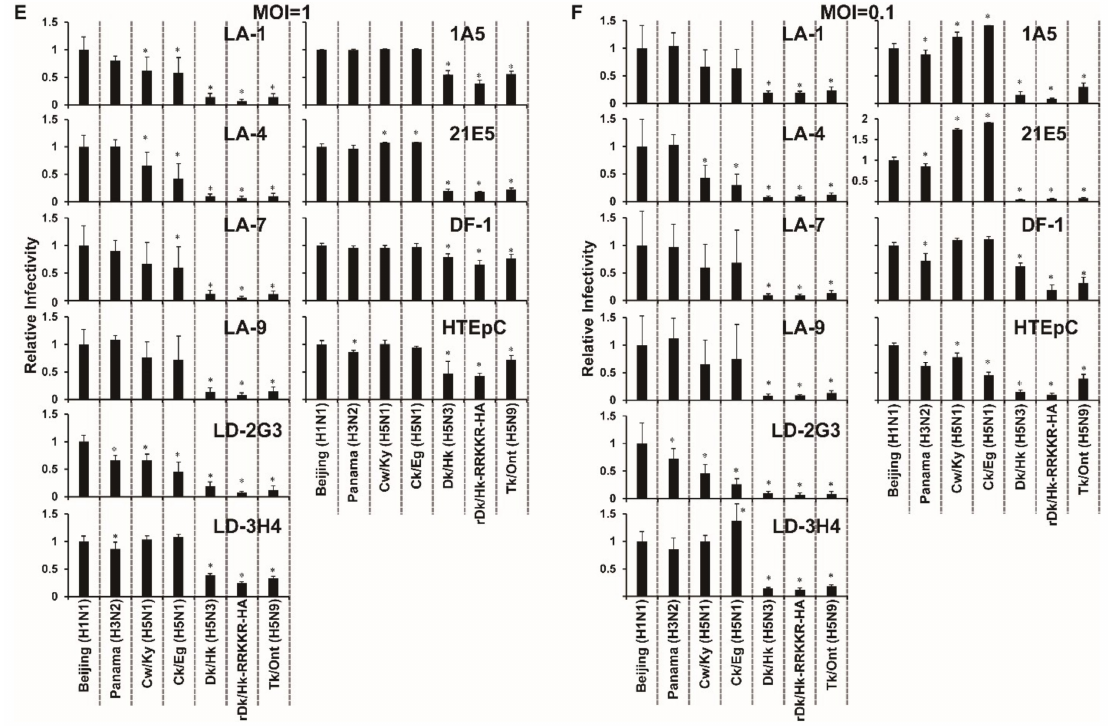
Figure 1. Susceptibility of human tracheal epithelial cell clones to infection by di ff erent viruses. ( A – C ) HTEpC-T clones were infected with human influenza viruses Beijing (H1N1) and Panama (H3N2); H5N1 (Cw / Ky (H5N1) and Ck / Eg (H5N1)); and previously circulating (non-zoonotic) AIVs Dk / Hk (H5N3), rDk / Hk-RRKKR-HA, and Tk / Ont (H5N9). All cells were infected at an m.o.i. of 10, 1, and 0.1. Viral infectivity was determined by calculating the percentage of antigen-positive HTEpC-T clones after immunostaining at 16 h post-infection. The susceptibility to infection of small airway epithelial cell (SAEC)-T clones (1A5 and 21E5), which were derived from a region di ff erent from that of the tracheal tract, chicken-derived cells (DF-1), and primary HTEpCs, was compared with that of the HTEpC-T clones. Data are expressed as the mean ± SD of 11 (LD-2G3 and LD-3H4) or 10 (other cell clones) independent results. ( D – F ) Relative cell susceptibility to infection was normalized using the infectivity of Beijing (H1N1). Asterisks indicate that the infectivity of each virus was significantly di ff erent from that of Beijing (H1N1) within the same graph. A p -value < 0.01 (asterisk) was considered significant (one-way ANOVA followed by Dunnett’s multiple comparisons post-hoc